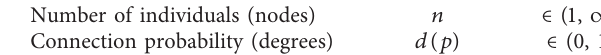
Table 1: Network property (two parameters).